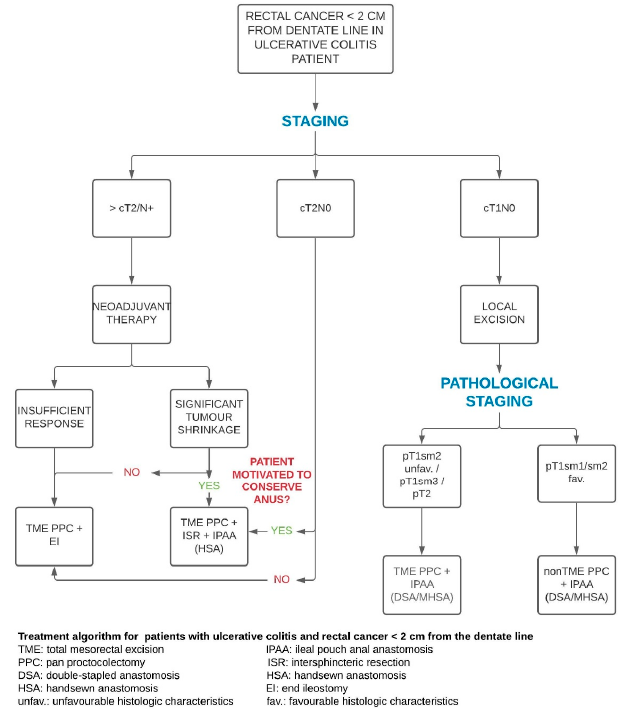
Figure 6. Treatment algorithm for patients with ulcerative colitis and rectal cancer < 2 cm from the pectinate line. pectinate